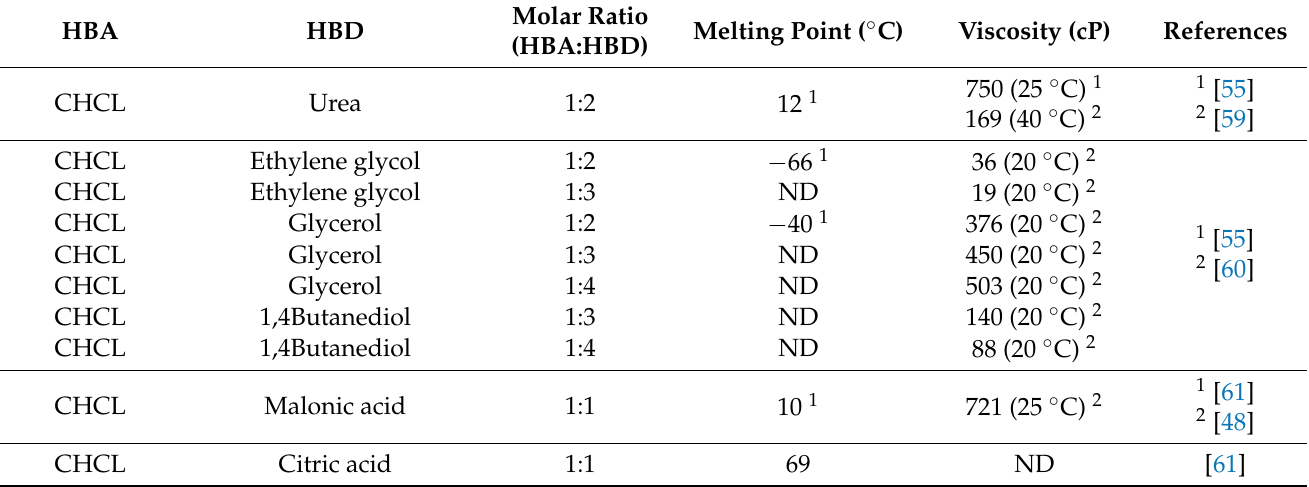
Table 1. Melting temperature and viscosity of selected